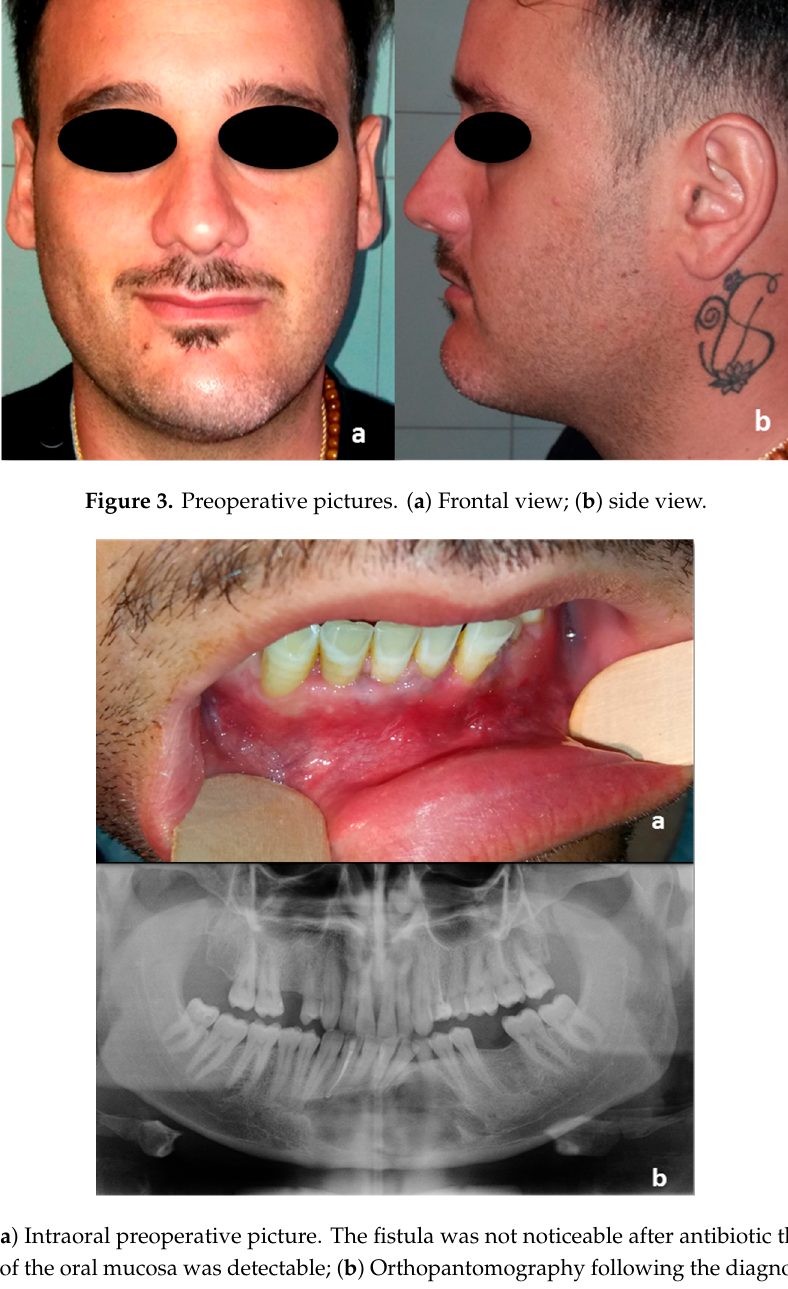
Figure 4. ( a ) Intraoral preoperative picture. The fistula was not noticeable after antibiotic therapy. No ulceration of the oral mucosa was detectable; ( b ) Orthopantomography following the diagnostic biopsy and lower canine extraction.